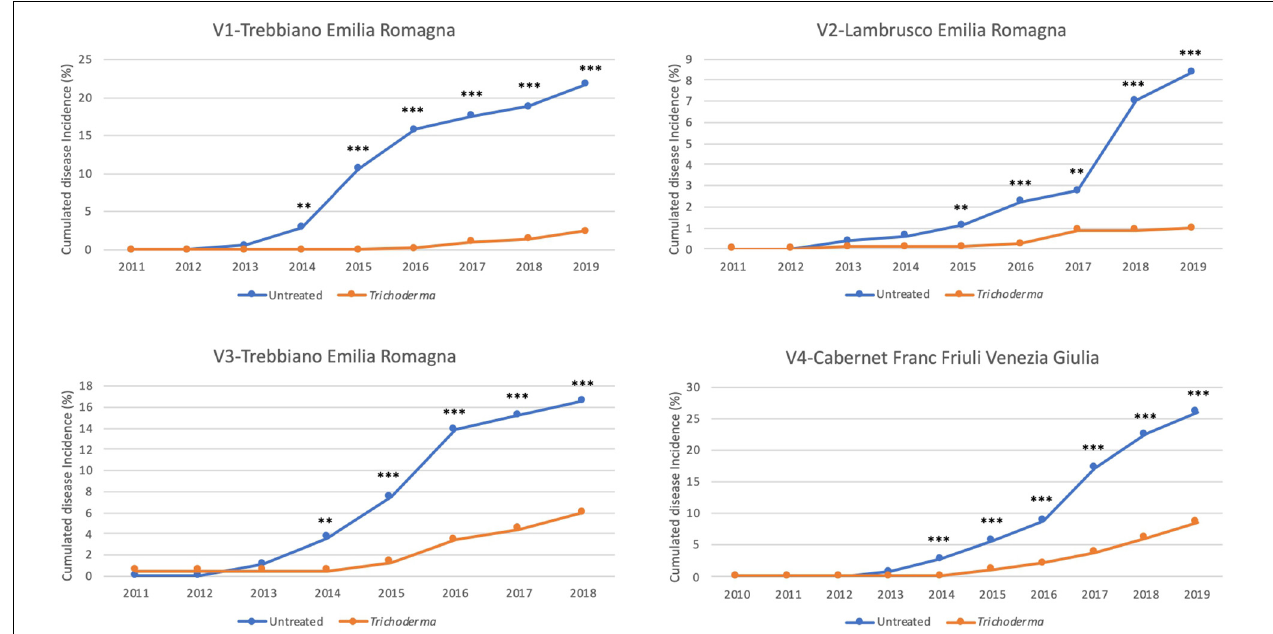
FIGURE 4 | Yearly cumulated disease incidence in the four young asymptomatic vineyards monitored for 8–10 years. Data were analyzed by χ 2 test. All the plants of each plot were considered to compare Trichoderma and control treatments. Where differences in distribution between the two treatments were significant, asterisks were placed ( ∗∗ P < 0.01 and ∗∗∗ P < 0.001 significance levels,